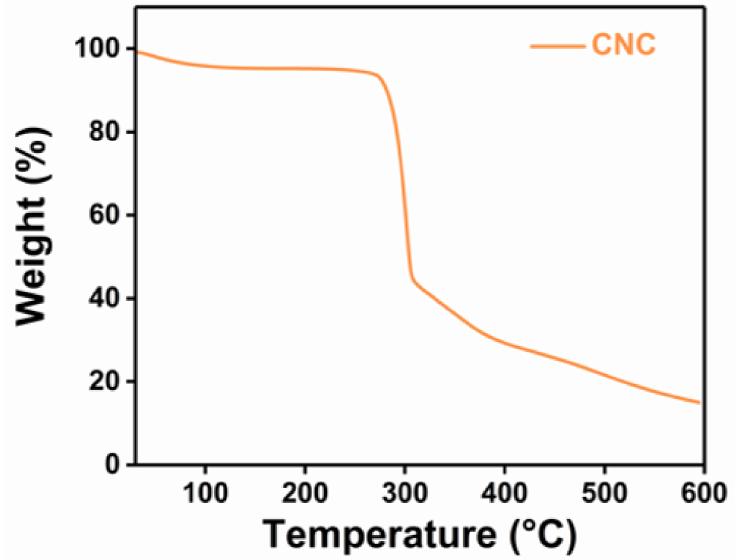
Figure A3. TG curve of